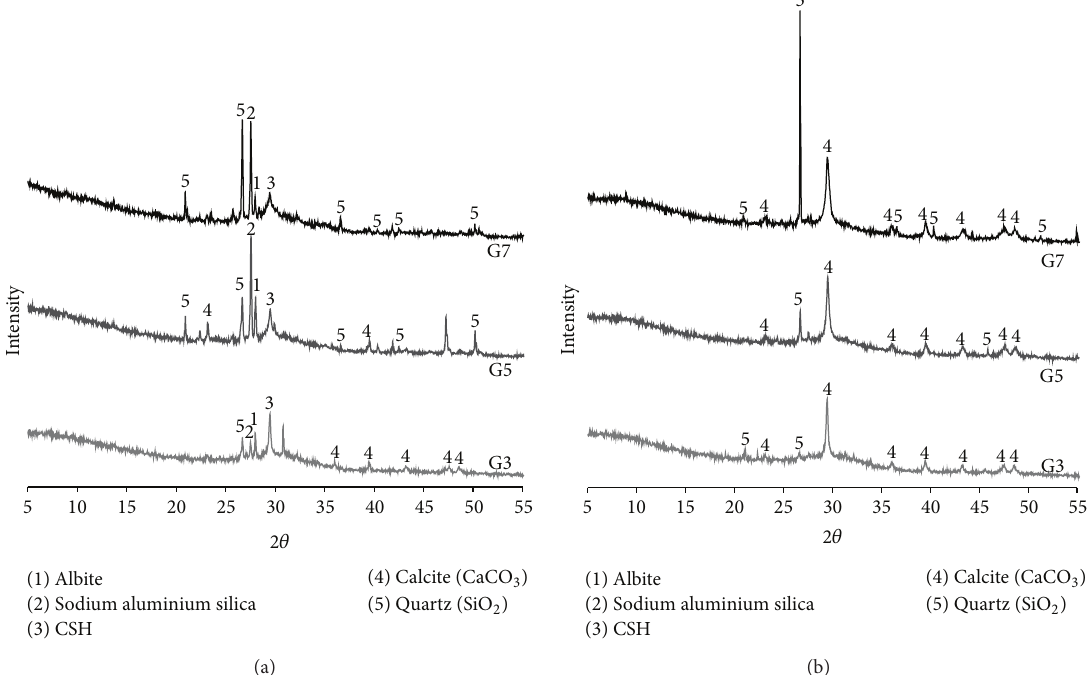
Figure 8: XRD diffraction patterns of noncarbonated (a) and carbonated (b) AAS mortar with different amounts of Na 2 O/S . M.